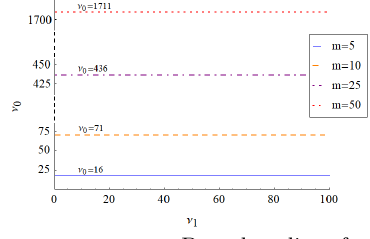
Figure 10. Boundary lines for comparison of T 2 and T 6